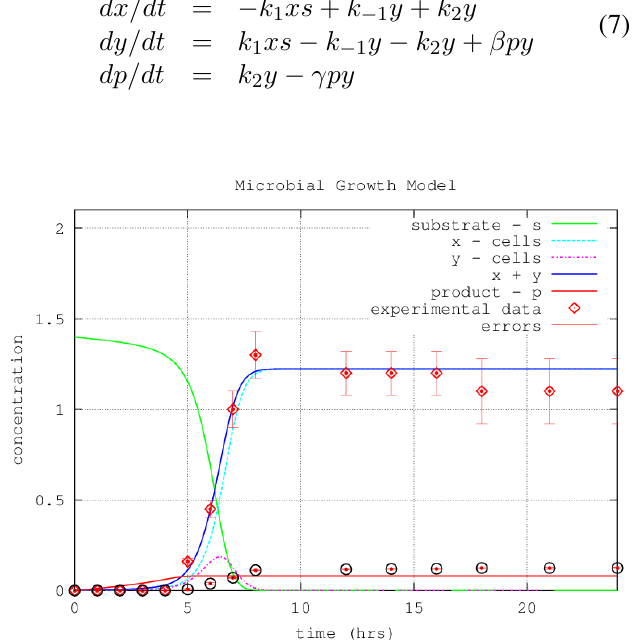
Fig. 1. Numerical solution of cell growth model (7) using Matlab The values of the parameters used in model (7) are as follows: k 1 = 3 . 48691 , k − 1 = 0 , k 2 = 7 , β = 41 . 5095 , γ = 86 . 4424; s = 1 . 4 , x = 0 . 00450748 . The 0 0 graphs of the solutions are represented in Fig.